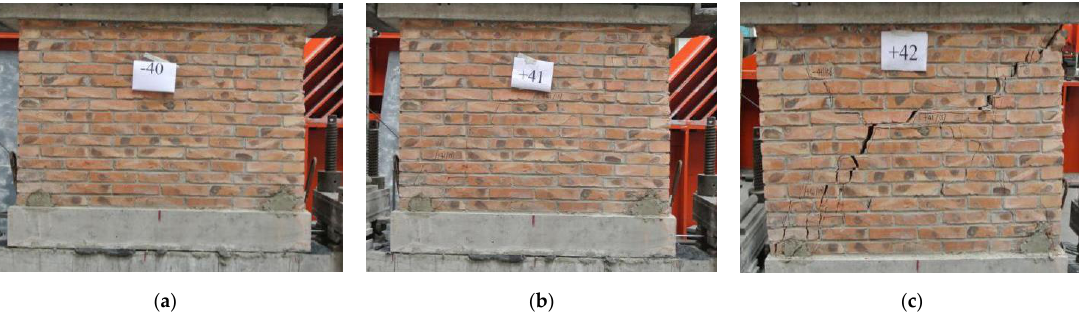
Figure 12. Failure process of GGBW-3: ( a ) slide isolator; ( b ) preliminary cracking; ( c ) specimen